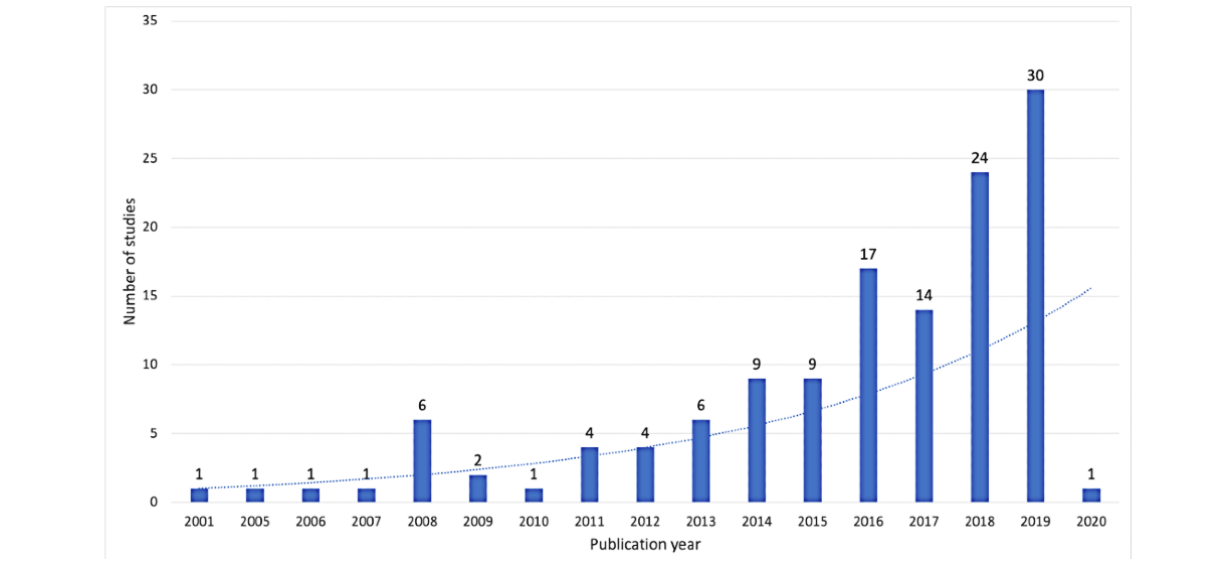
Figure 2. Distribution of selected studies (N=131) by year of publication.